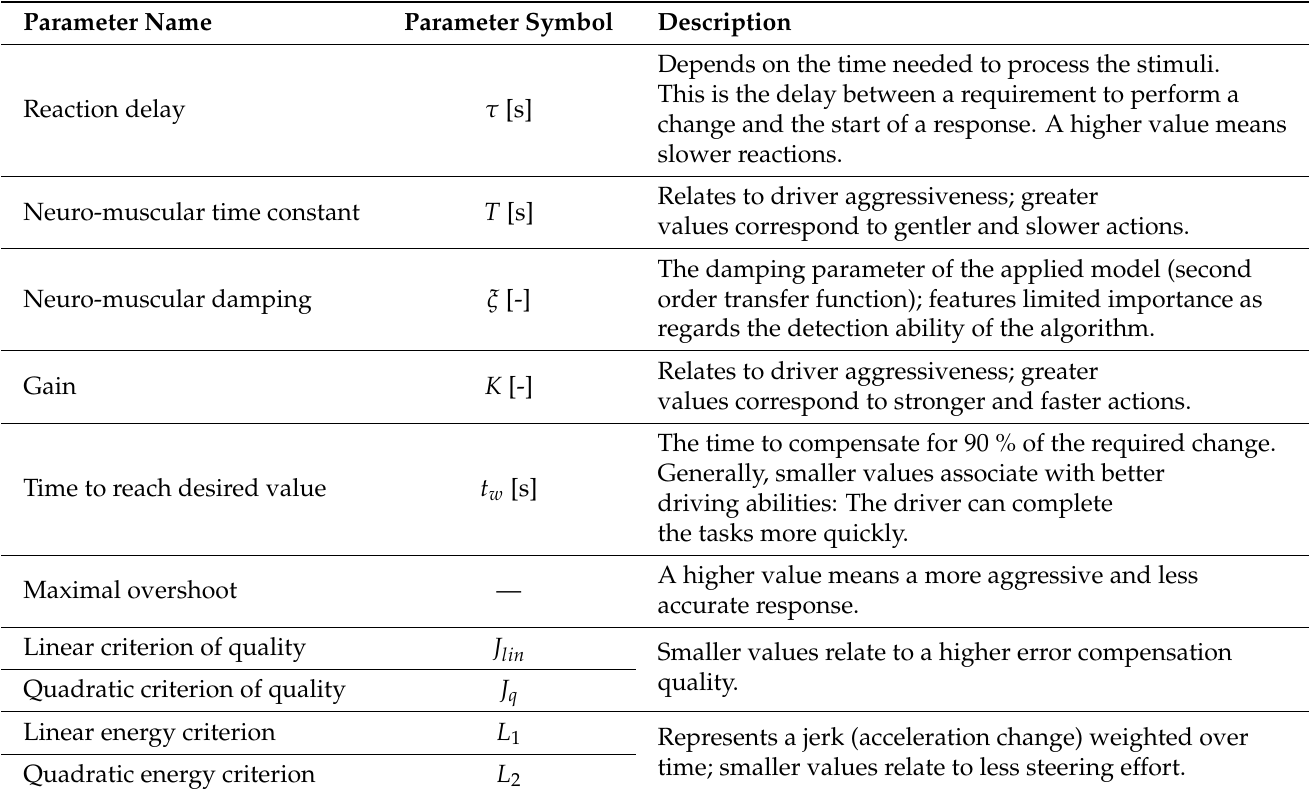
Table 1. Table of Derived parameters from measured